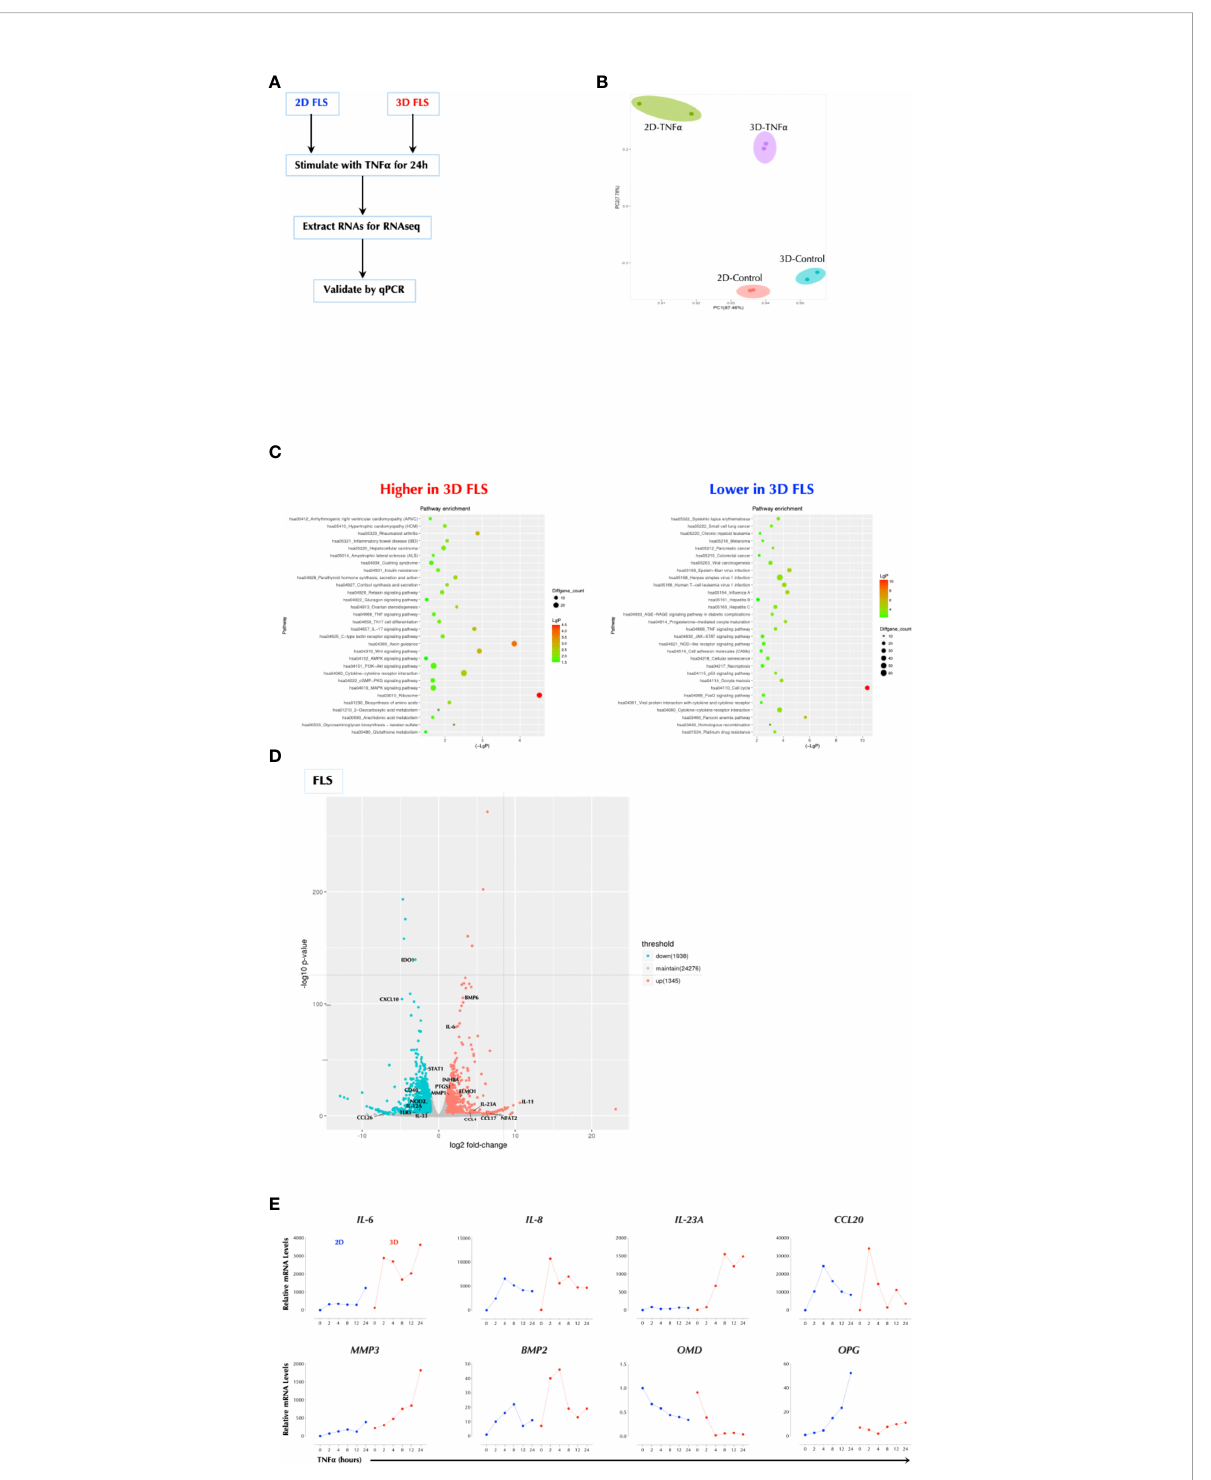
FIGURE 1 Cell Culture Matrix Regulates the TNF response. (A) Experimental schema. FLS were cultured in plastic tissue culture plate (2D) for 2 days or Vitrogel for 7 days and stimulated with TNF a (1ng/ml) for 2h in duplicates. Total RNAs were collected and subjected to RNAseq. (B) Principal component analysis (PCA) of RNAseq data. (C) Pathway analysis of RNAseq data. (D) A volcano plot of differential induced genes. (E) Validation of RNAseq data by qPCR analysis. FLS were cultured in plastic tissue culture plate (2D) for 2 days or Vitrogel for 7 days and stimulated with TNF a (1ng/ml) for the indicated time periods. The results are the representative of several similar